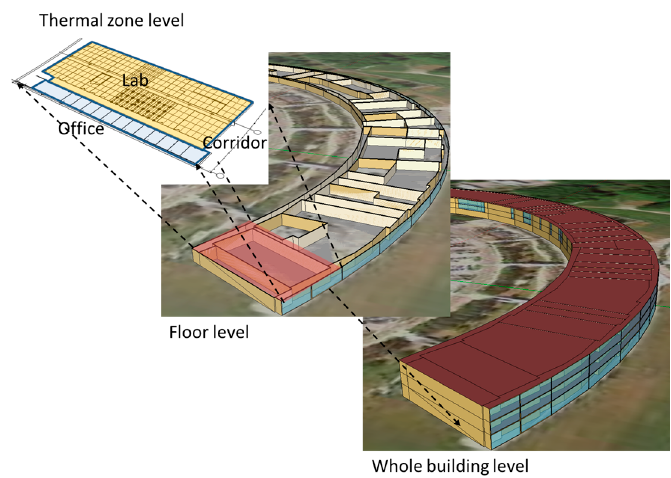
Figure 2. Hierarchical diagram of the geometry in modelling.